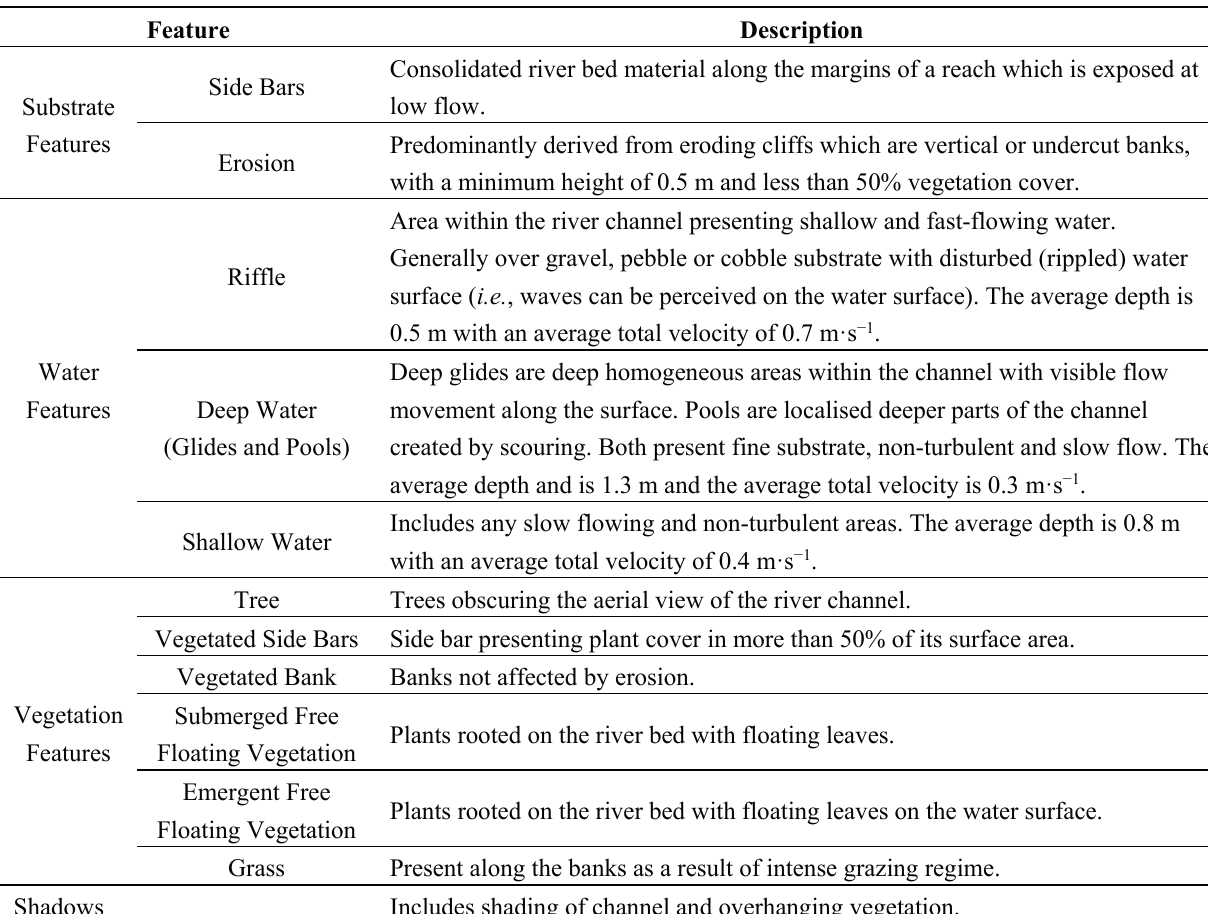
Table 2. Hydromorphological features identified within the study area based on